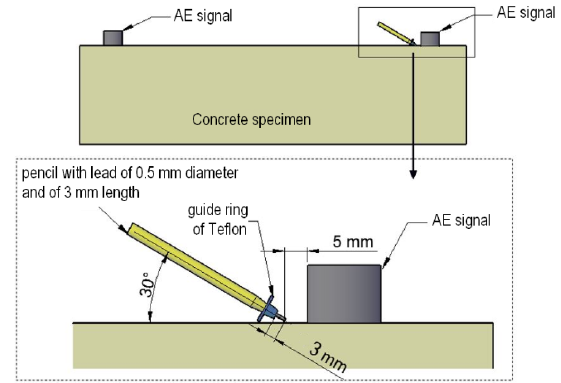
Figure 8. Sensor calibration before testing — Hsu Nielsen source.